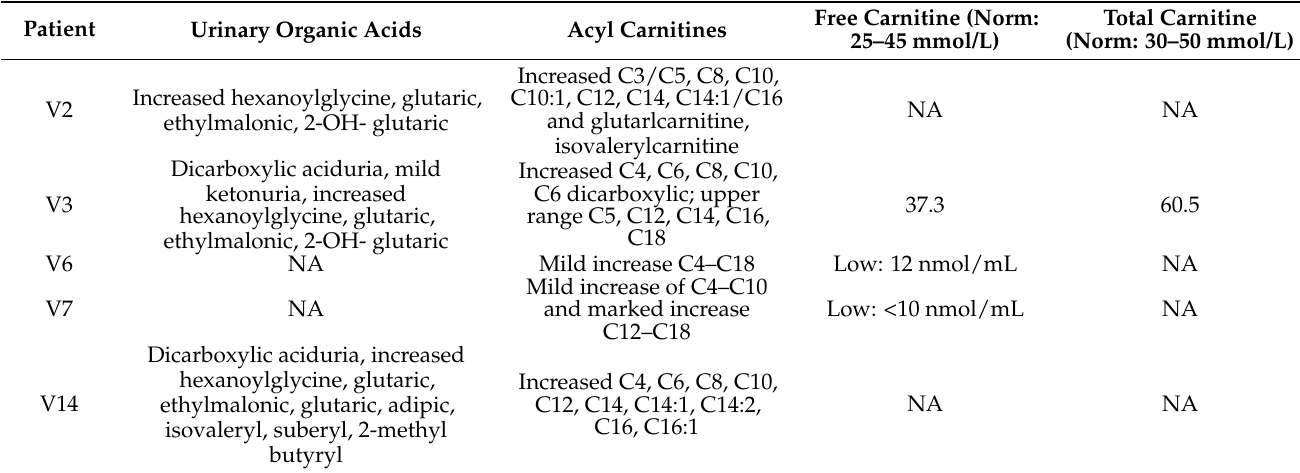
Table 1. Patients’ biochemistry